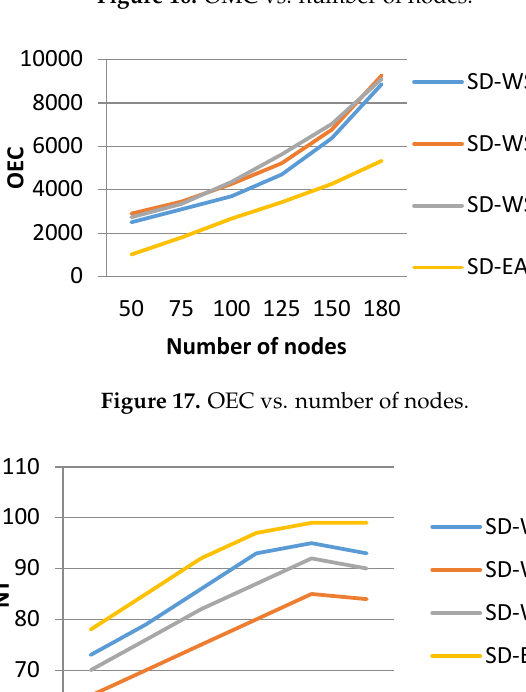
Figure 16. OMC vs. number of nodes.